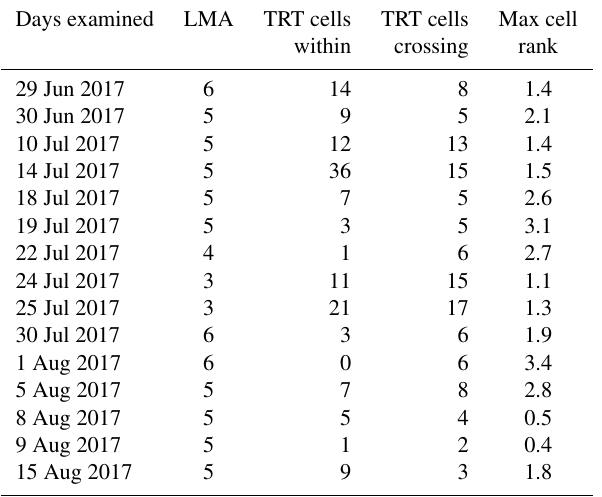
Table 2. Analysed days with some of their general characteristics. The LMA domain refers to the yellow area in Fig. 1. The cells considered have a lifespan of at least three radar time steps (i.e. 15min) and have been present within the domain for at least three time